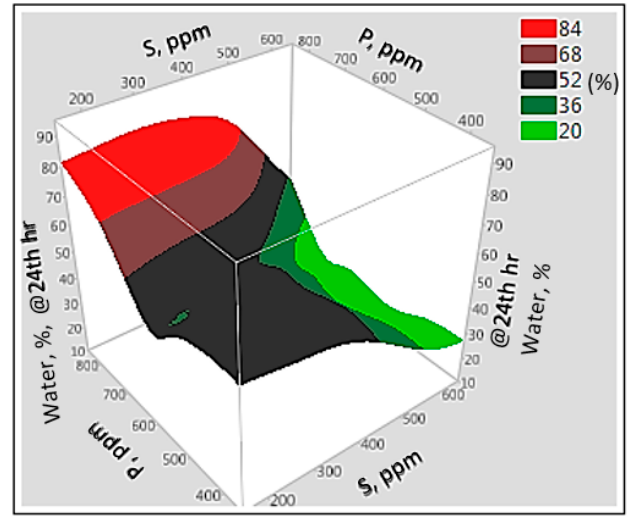
Figure 14. E ff ect of the surfactant–polymer on separation.